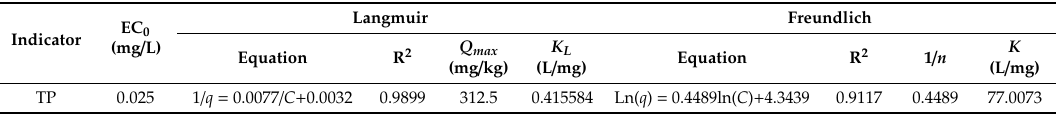
Figure 3. Characteristics of total phosphorus (TP) adsorption and release in sediments of Biliuhe reservoir: ( a ) TP adsorption characteristic; ( b ) TP release characteristic. Table 2. Parameters of the fitting equations about total phosphorus (TP) adsorption and release characteristics in sediments of Biliuhe reservoir.